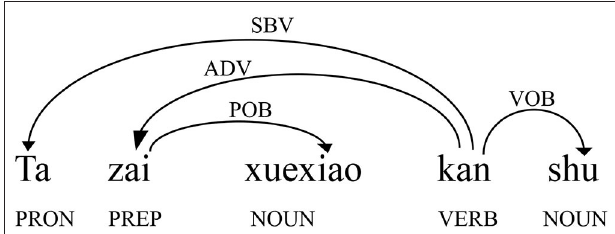
directed network shown in Figure 2 . In this figure, the